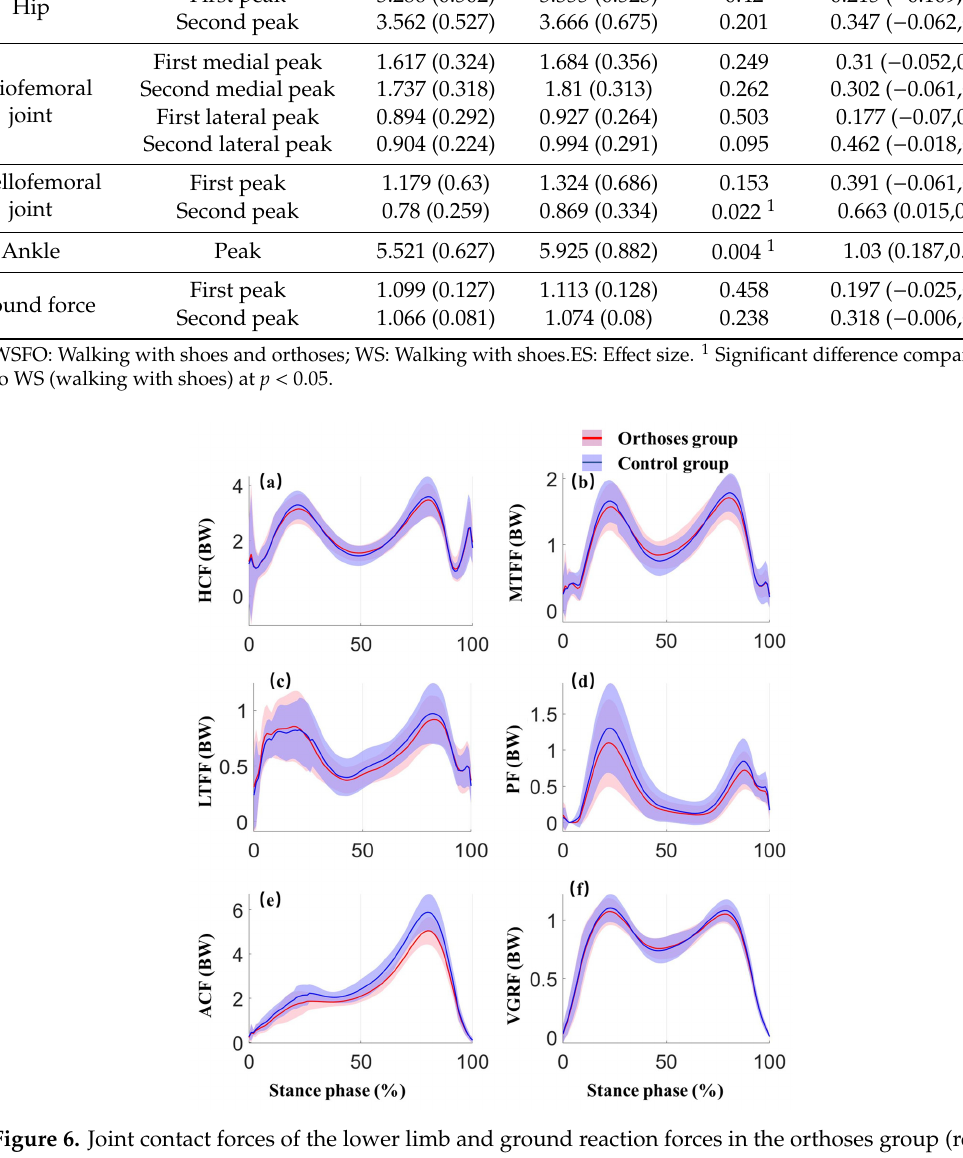
Table 3. Peak amplitude of joint force and vertical ground reaction force between two walking conditions during stance (BW).